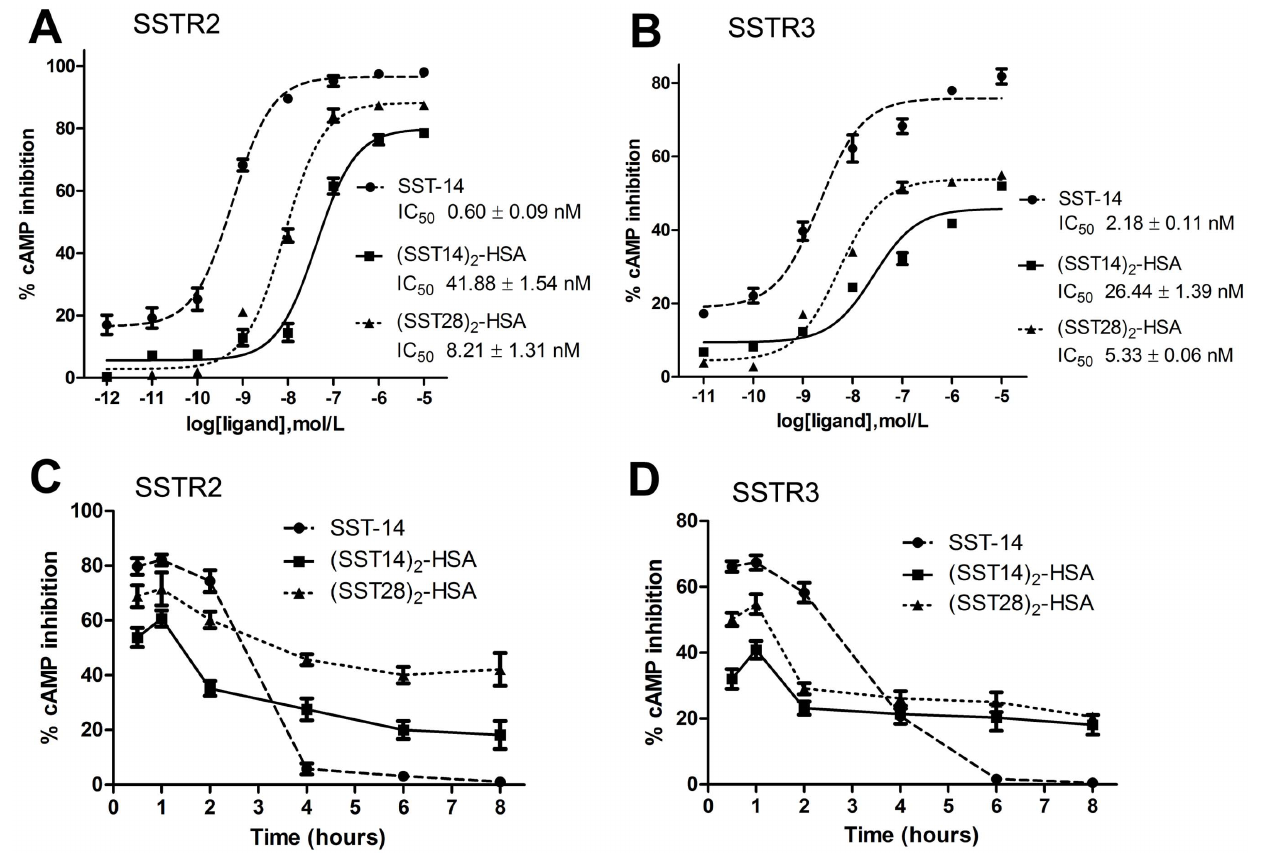
Figure 5. Comparison of SST-14-, (SST14) 2 -HSA- and (SST28) 2 -HSA-induced adenylyl cyclase inhibition in SSTR2- and SSTR3- expressing cells. (A, B) Dose-dependent inhibition for forskolin-stimulated cAMP accumulation. HEK 293 cells expressing SSTR2 or SSTR3 were exposed to 25 m M forskolin plus SST-14, (SST14) 2 -HSA or (SST28) 2 -HSA in concentrations ranging from 10 2 12 to 10 2 5 M for 15 minutes. Cells were lysed and cAMP levels were determined using a cAMP ELISA kit. The maximum forskolin-stimulated cAMP formation in the absence of agonist was defined as 100%. Values represent the means 6 S.E. of three separate measurements performed in triplicate. The half-maximal inhibitory concentrations (IC50) were analyzed by nonlinear regression curve fitting using GraphPad Prism 5.0. (C, D) Time-dependent inhibition for forskolin- stimulated cAMP accumulation. HEK 293 cells expressing SSTR2 or SSTR3 were pre-treated with 1 m M SST-14, (SST14) 2 -HSA or (SST28) 2 -HSA, at 0.5, 1, 2, 4, 6, 8 hour time points, cells were exposed to 25 m M forskolin for 15 minutes. Cells were lysed and cAMP levels were determined using a cAMP ELISA kit. The maximum forskolin-stimulated cAMP formation in the absence of agonist was defined as 100%. Values represent the means 6 S.E. of three separate measurements performed in triplicate. around 5 minutes, but less potency than SST-14 in same molecular concentration (Figure 4C, D). Compared with (SST14) 2 -HSA, (SST28) 2 -HSA had more potency for induction of ERK1/2 phosphorylation (Figure 4C, D).